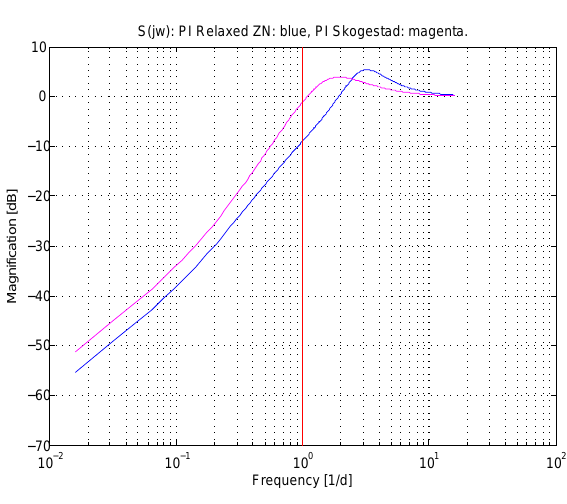
Figure 13: Bode plot of the magnitude of the sensitivity function of the control loop for two different PI controller